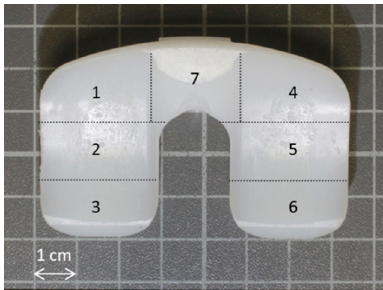
Figure 2. Polyethylene inlay with typical traces of wear. For the determination of the Hood score, the inlay was divided into seven zones.